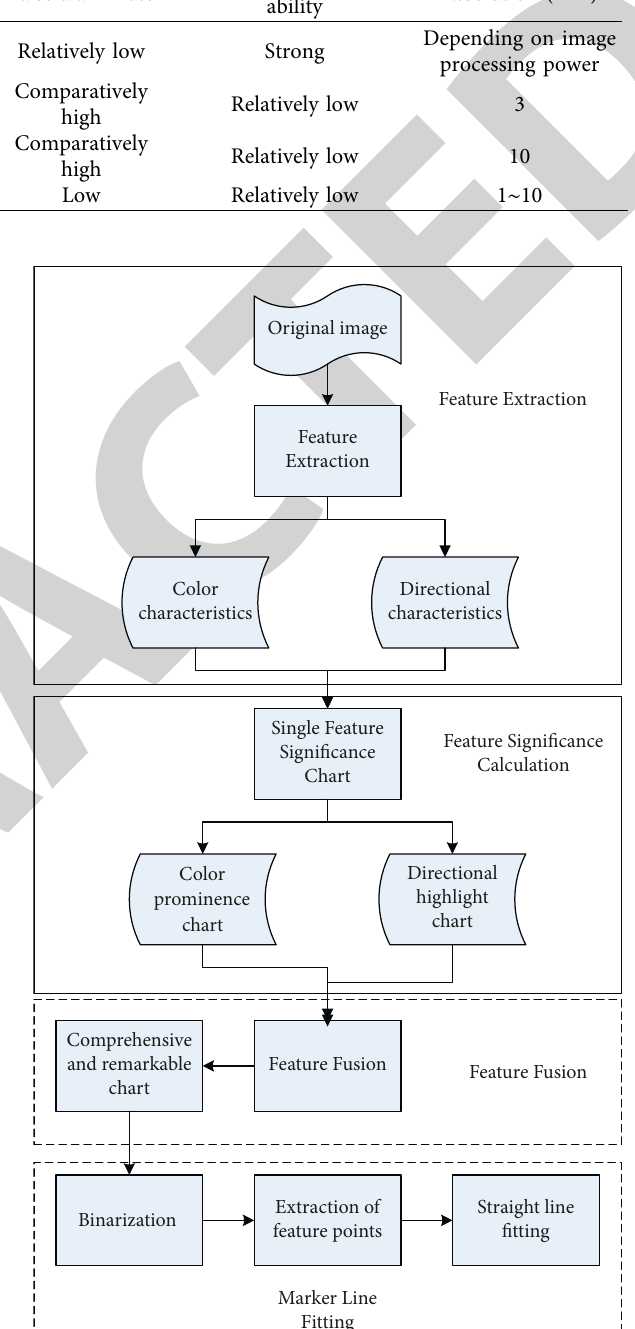
Figure 2: Lane line fitting algorithm